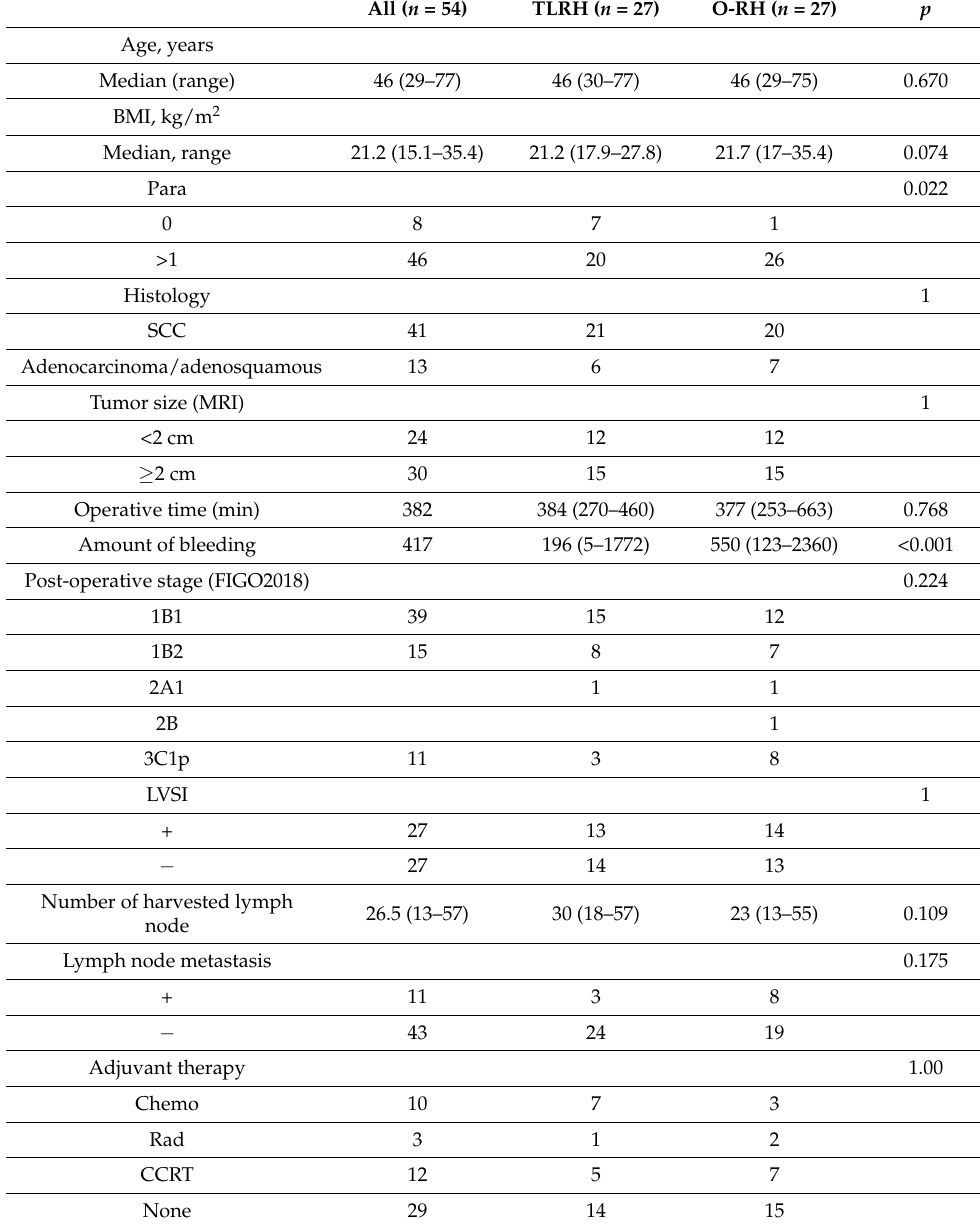
Table 2. Propensity score matching of 54 cases, balanced for tumor size, post-operative stage, and lymph node